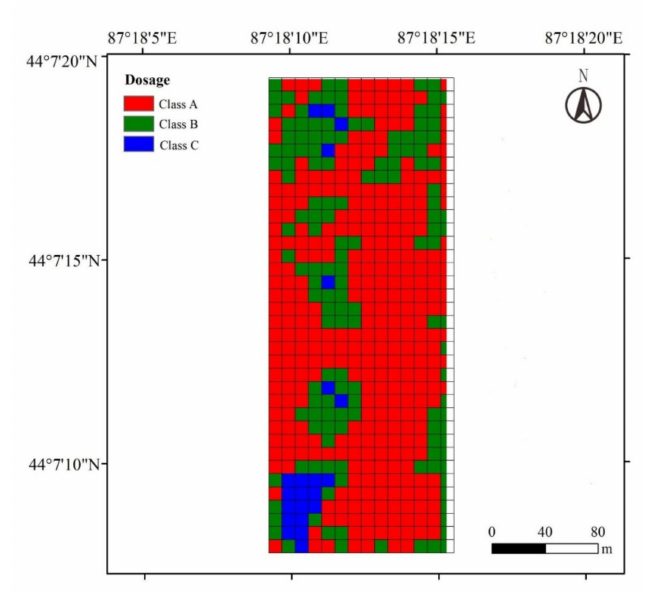
Figure 9. Spraying prescription map of the cotton defoliation